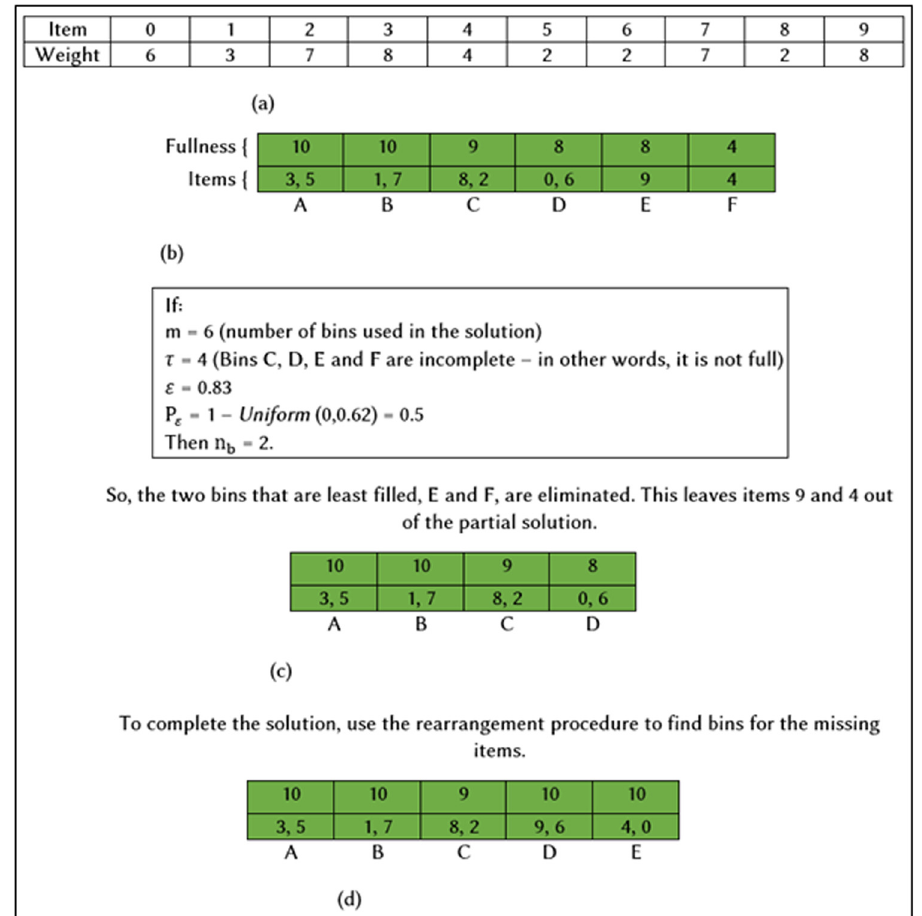
Figure 12: An example of the adaptive mutator with RP operator. ( a ) An example of the list of items in a BPP instance. ( b ) An example of an individual in the population with bin capacity of 10. ( c ) Partial solution after elimination of two bins. ( d ) The completed child solution. Source: [ 35 ]